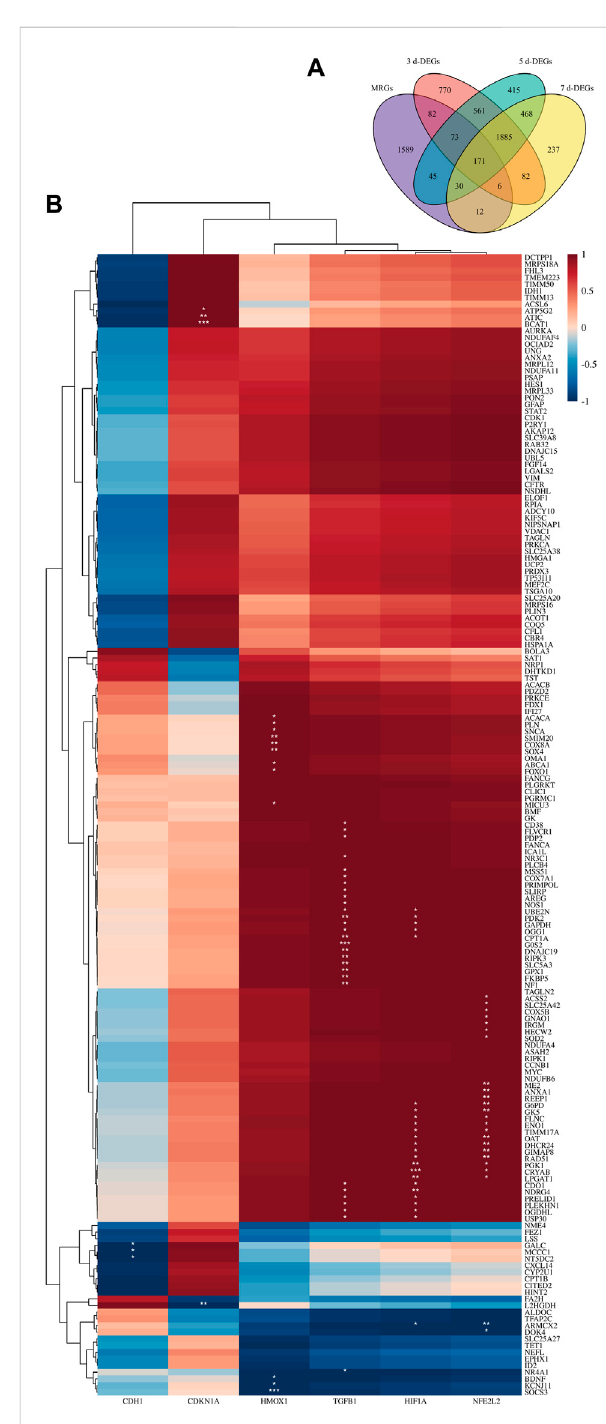
FIGURE 5 Correlation between hub genes and mitochondria. (A) Venn diagram shows the DE-MRGs. (B) The clustering correlation heatmap revealed the correlation between 171 DE-MRGs and 6 hub genes. The clustering results are displayed to the image ’ s left and top. The color bars represent the correlation between genes. A deeper red indicates a stronger positive correlation, while a deeper blue indicates a stronger negative one. * denotes signi fi cance level, * p < 0.05, ** p < 0.01, *** p <